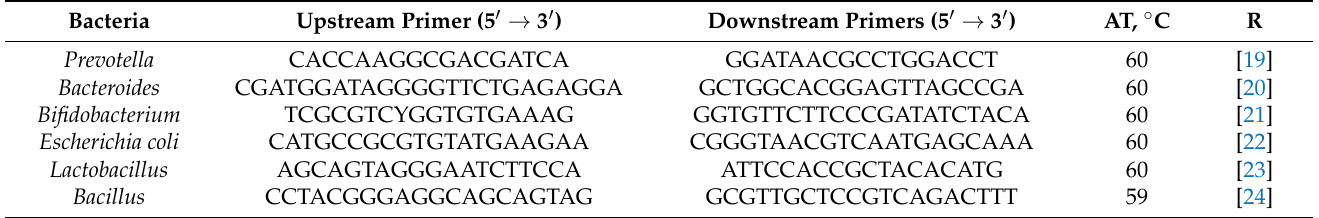
Table 2. Primer sequence for fecal